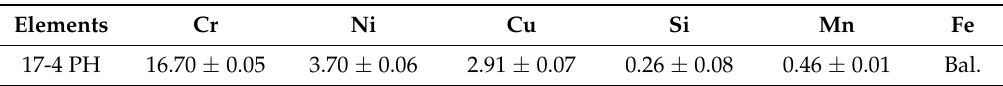
Table 1. The measured chemical composition of 17-4 PH stainless steel before laser treatment (all in